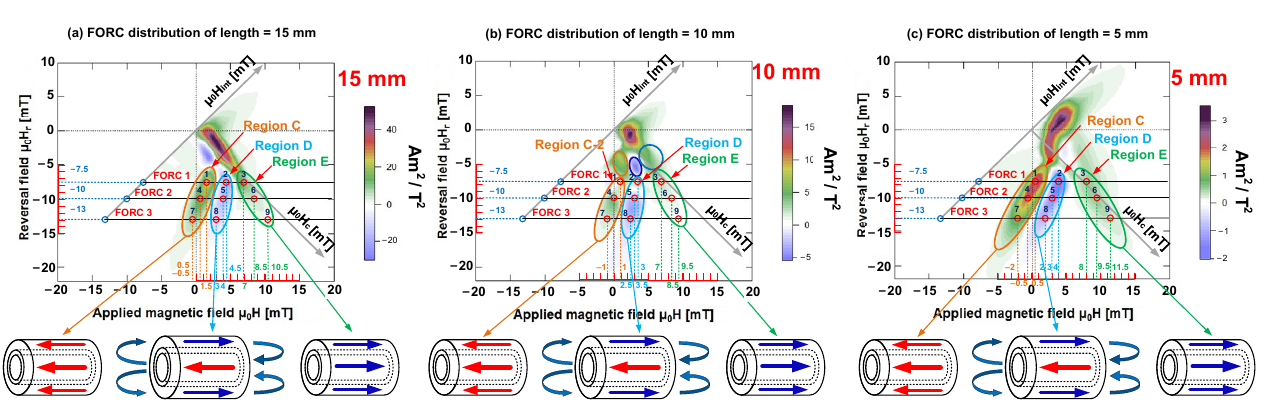
Figure 11. Three FORC diagrams with lengths of 15, 10, and 5 mm, and three FORCs with distinct